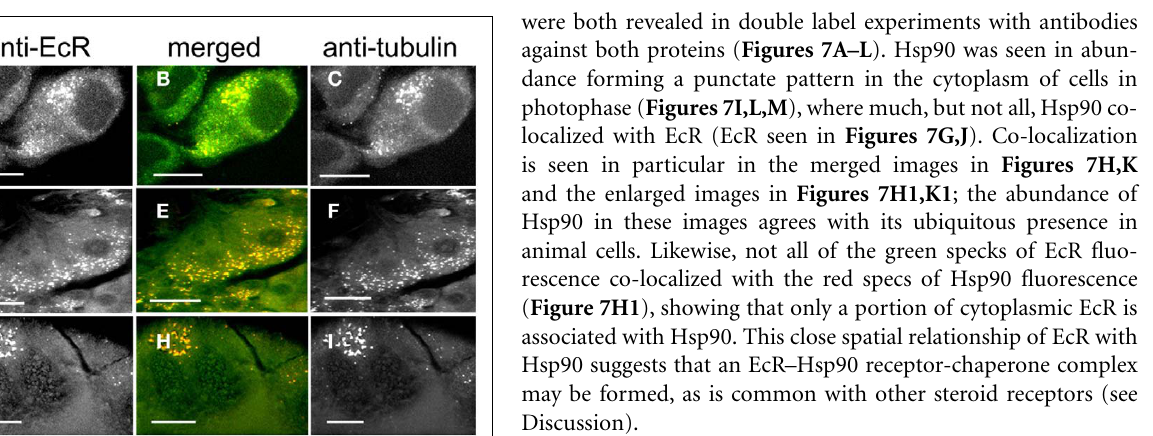
FIGURE 5 | Cells double-labeled with anti-EcR (left column, green) and anti-tubulin (right column, red). The merged column shows merged images of left and right. Co-localization is shown as yellow/orange. Cells were pre-incubated with the MT-stabilizing agent taxol. Large cells are oenocytes and small cells are epidermal cells. Both rows show different aspects of oenocytes. (C,F) Show the radial